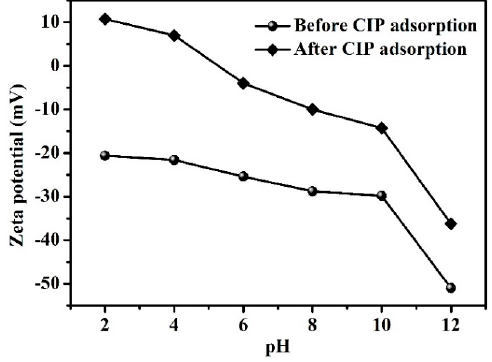
Figure 9. Zeta potential of HNTs in different pH condition.